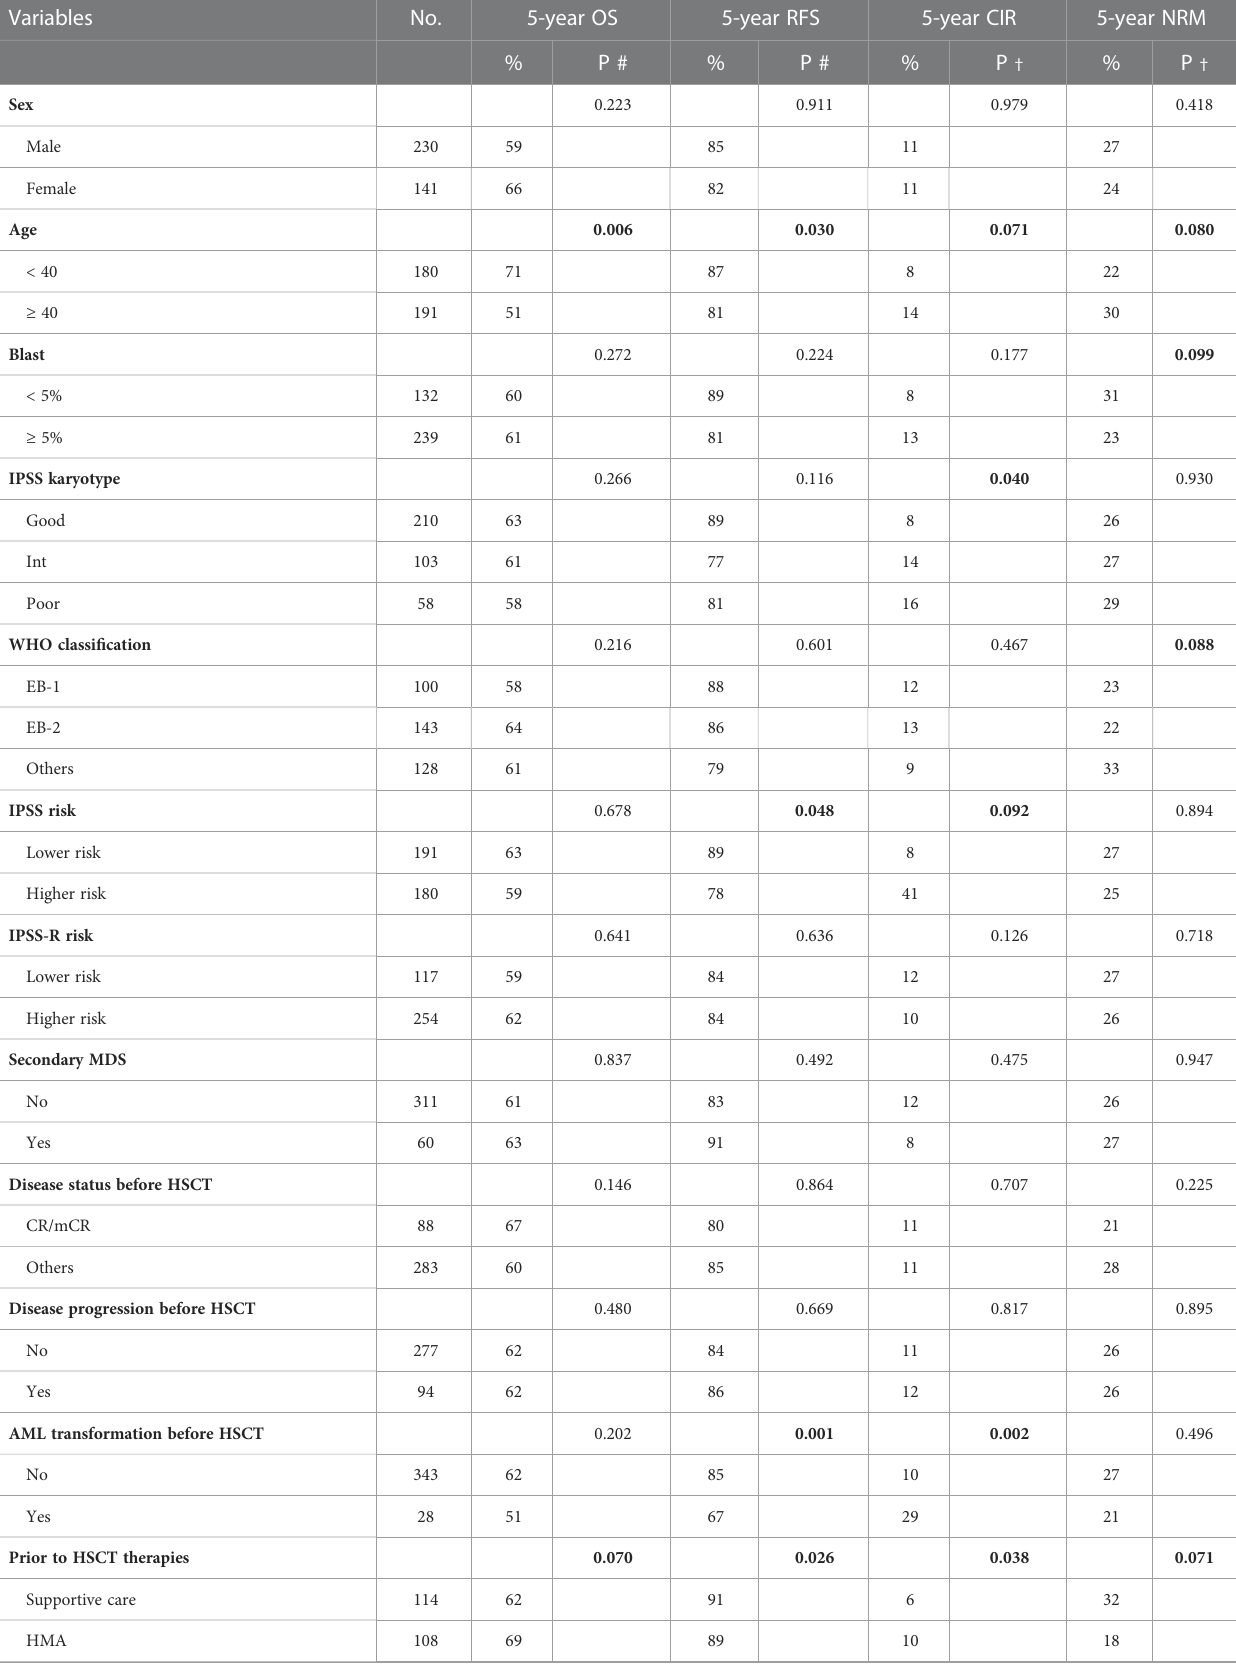
TABLE 2 Univariate analysis of prognostic factors for OS, RFS, cumulative incidence of relapse, and cumulative incidence of NRM.